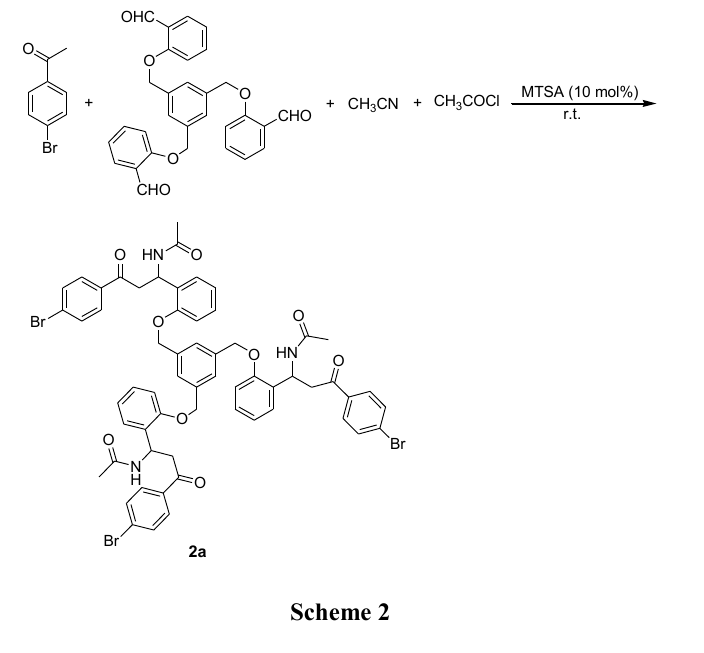
Table 3. Comparison of the results of the reaction of acetophenone with benzaldehyde, acetonitrile and acetyl chloride catalyzed by MTSA, with those obtained by the reported catalysts. Catalyst, Reaction Conditions Time, min Yield a , %